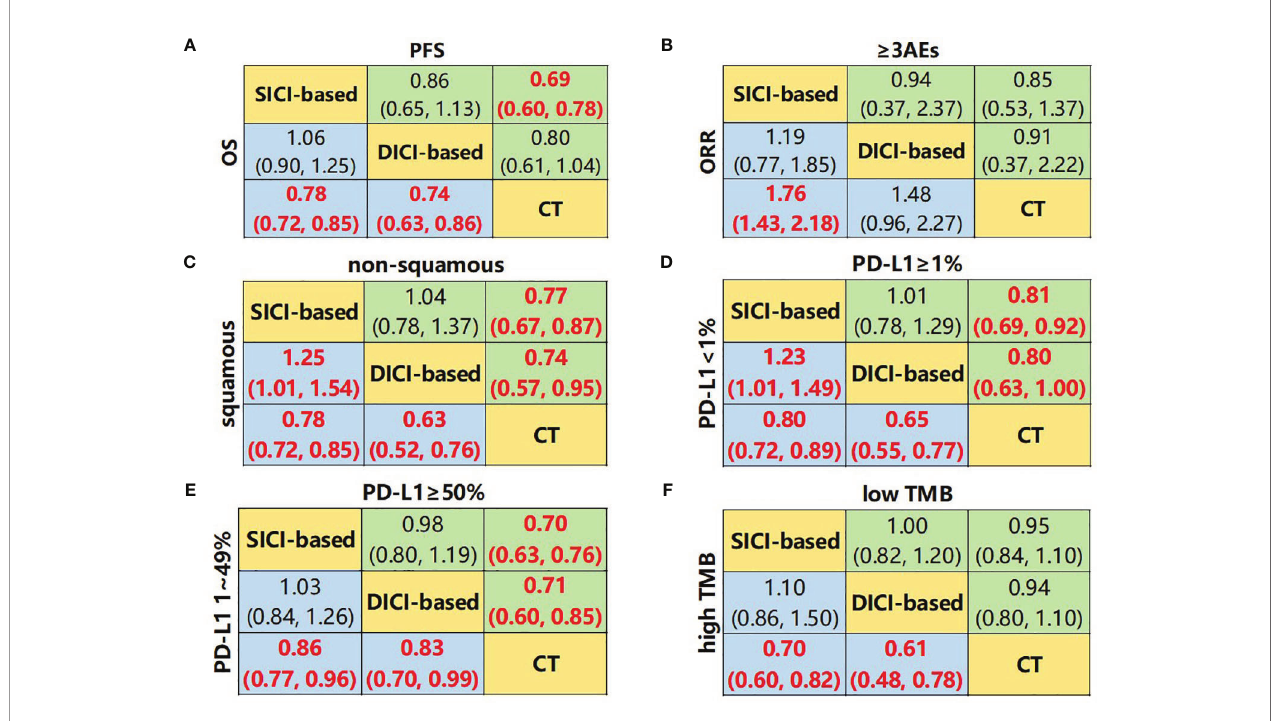
FIGURE 3 | Network meta-analysis composed of SICI- or DICI-based treatments and CT. (A) Pooled hazard ratio (HR) [95% CrIs (credible intervals)] for overall survival (OS) and progression-free survival (PFS) in the overall population. (B) Pooled odds ratio (OR) (95% CrIs) for objective response rate (ORR) and adverse events of grade 3 or higher ( ≥ 3AEs) in the overall population. (C) Pooled HR (95% CrIs) for OS of squamous and non-squamous subgroups. (D) Pooled HR (95% CrIs) for OS of PD-L1 <1% and PD-L1 ≥ 1% subgroups. (E) Pooled HR (95% CrIs) for OS of PD-L1 1% – 49% and PD-L1 ≥ 50% subgroups. (F) Pooled HR (95% CrIs) for OS of high TMB and low TMB subgroups. Data in each cell are HR or OR (95% CrIs) for the comparison of upper row-de fi ning treatment vs . lower row- de fi ning treatment. HR less than 1 and OR more than 1 favor upper-row treatment. Signi fi cant results are highlighted in red and bold. SICI-based, treatments including single immune checkpoint inhibitor; DICI-based, treatment including double immune checkpoint inhibitors; CT,